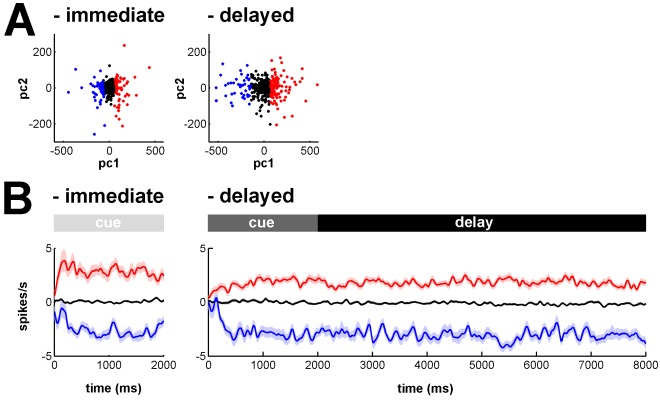
Clustering analysis of MSN activity profiles in the immediate and delayed conditions.